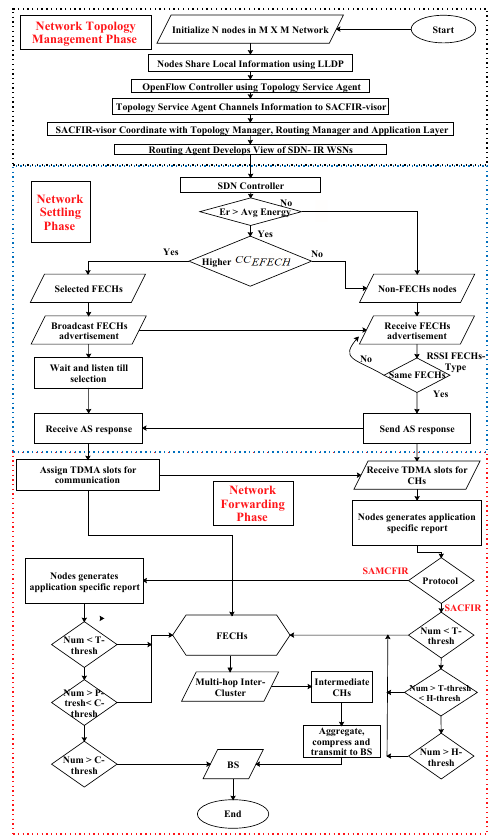
Figure 7. Flow chart proposed